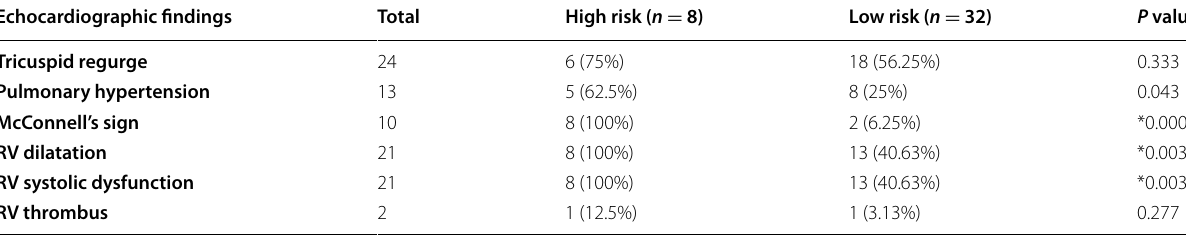
*Significant P value <